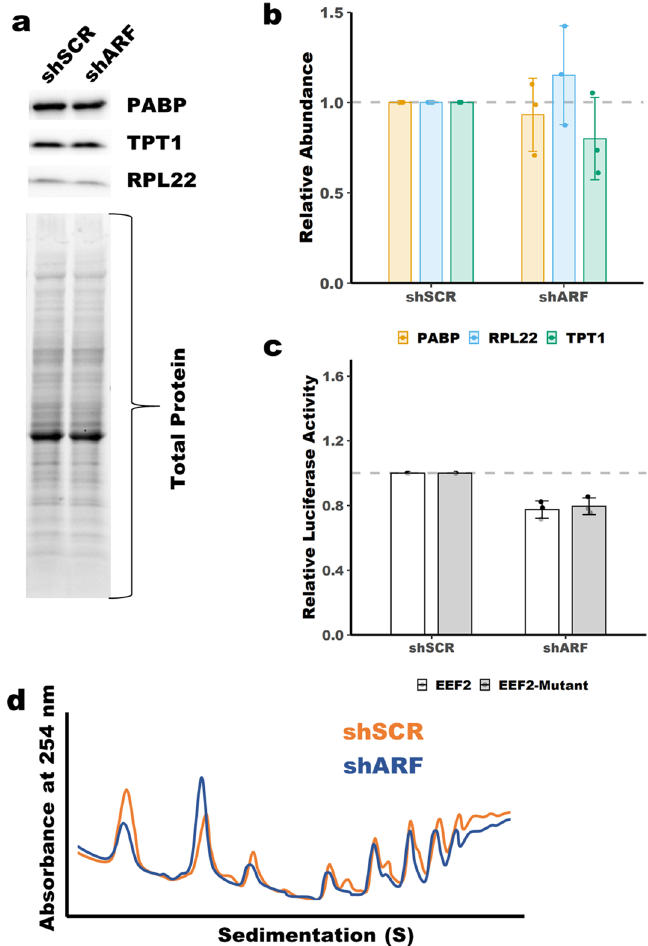
Figure 4. 5 ′ -TOP expression is unaffected by ARF knockdown in p53 −/− MEFs. ( a ) Immunoblot analysis showing no change in protein abundance of PABPC1, TPT1 and RPL22 following ARF knockdown in p53 −/− MEFs. ( b ) Quantitation of blots in panel ( a ). Total protein was used for normalization. Mean ± SD, n = 3. ( c ) No change in luciferase activity of a 5 ′ -TOP reporter following ARF knockdown in p53 −/− MEFs. Luciferase activity was normalized to Renilla luciferase transfection control and set relative to shSCR. Mean ± SD, n = 3. ( d ) Polysome profiling showing no change in polysome peaks in p53 −/− MEFs following knockdown of